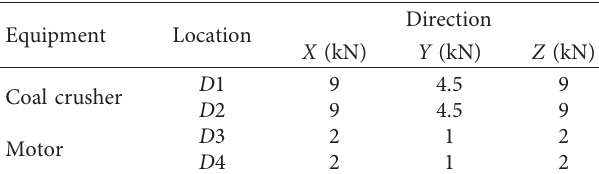
Table 3: Disturbing forces of coal crusher